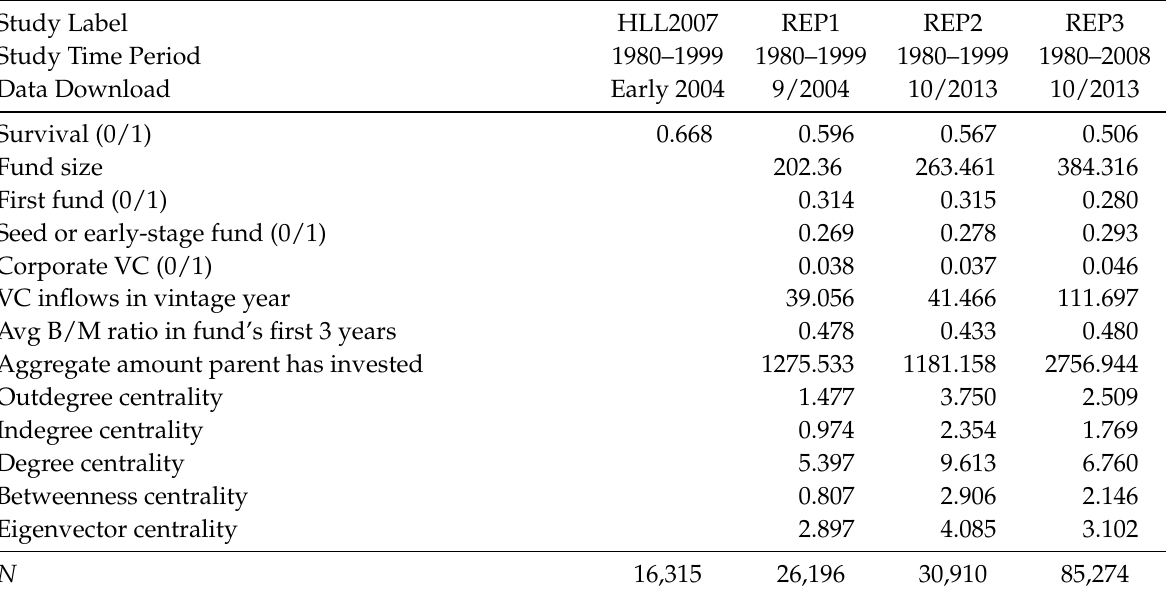
Table 3: Company-level variable means for HLL2007 and three replication